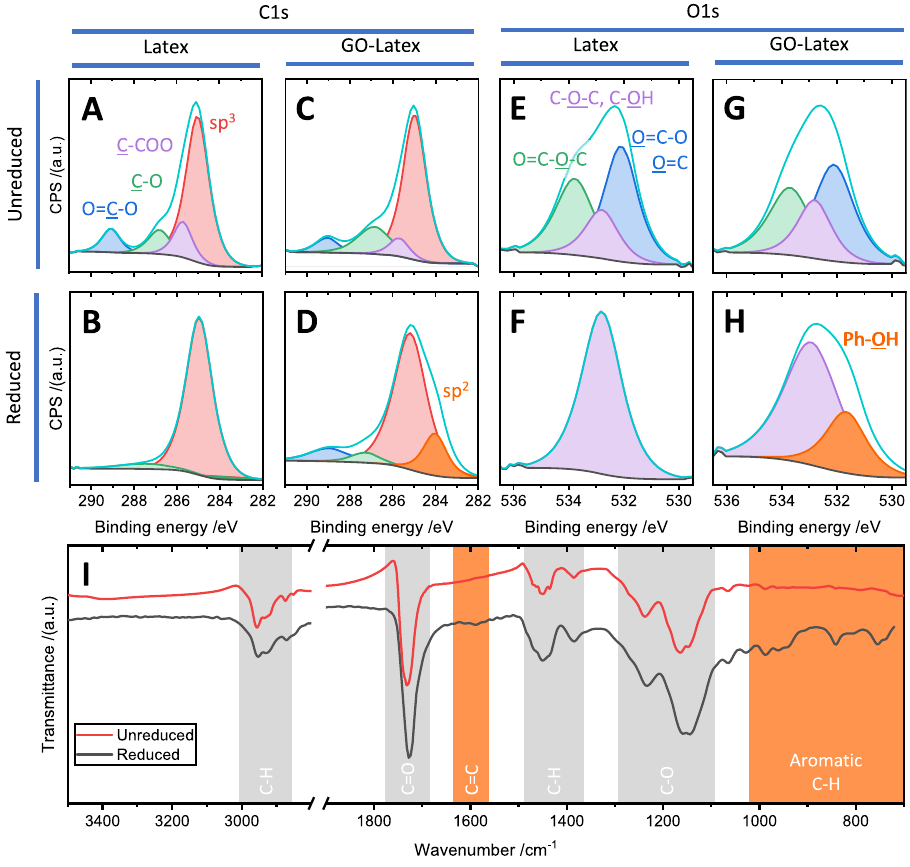
Fig.4|Chemicalspectroscopyofnanocomposites.A – H FittedXPSdatashowing the C1s ( A – D ) and O1s ( E – H ) features. The unreduced ( A , C , E , G ) and reduced ( B , D , F , H ) samples are investigated for the pristine latex polymer and 2wt% GO